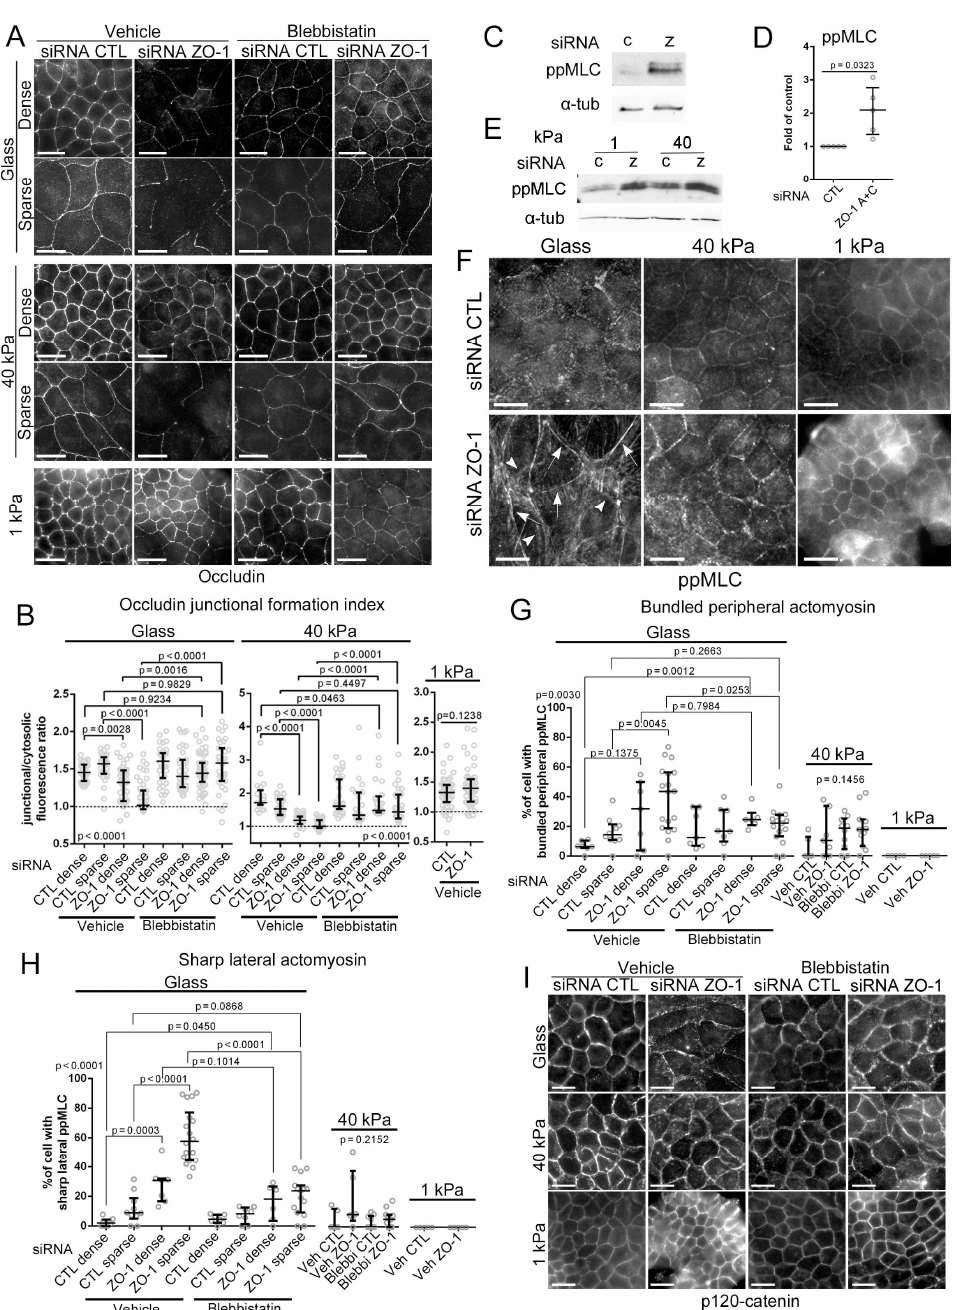
Figure 2. ZO-1 is required for junction formation on stiff ECM. ( A , B ) TJ formation by siRNA-transfected MDCK cells plated on ECM of different stiffnesses was analysed by immunofluorescent staining of occludin. Cells were either treated with DMSO (vehicle) or blebbistatin for 24 h. Quantification of junction formation was performed by measuring single-junction ratios of junctional to cytosolic occludin fluorescence intensity number of cells in each condition ( B ). ( C – E ) Actomyosin activ- ity was evaluated by immunoblotting for ppMLC and α -tubulin as a loading control. Panel ( D ) shows quantification of the ppMLC levels by densitometry of cells plated on glass (data points are independent determinations). ( F – H ) Immunofluorescence of ppMLC was also performed in cells grown on glass or hydrogels to analyse the distribution of active myosin within cells. The percentage of cells per image displaying thick peripheral ppMLC bundles (( G ); labelled in panel ( F ) with ar- rowheads) and sharp lateral ppMLC (( H ); labelled in panel ( F ) with arrows) were manually quanti- fied considering areas with densely and sparsely populated cell areas (n, number of images in each condition). ( I ) Cells were stained for the AJ marker p120-catenin. Magnification bars, 20 μ m.